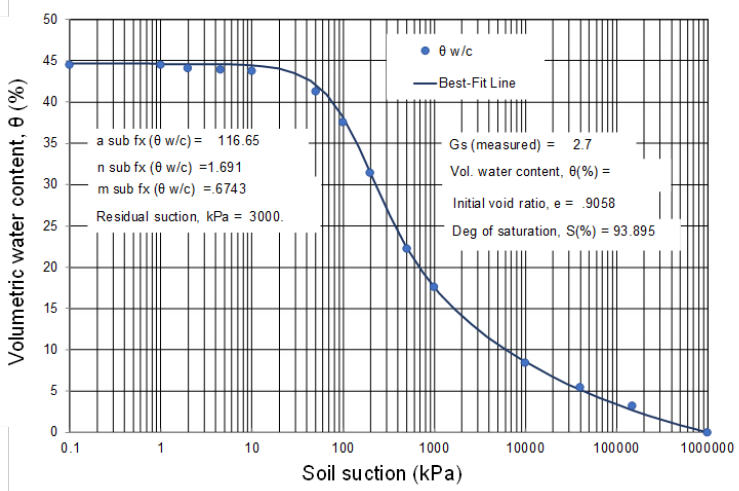
Figure 17. Graphical presentation of the volumetric water content versus soil suction during drying ( θ -SWCC) regression analysis